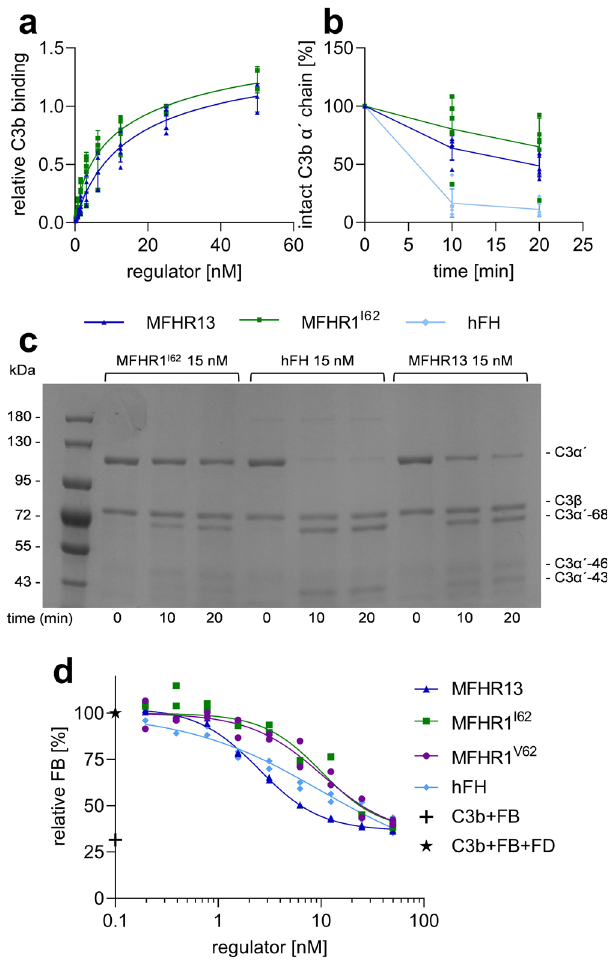
Fig. 6 MFHR13 binds to C3b and exhibits cofactor and decay acceleration activities in fl uid phase. a C3b binding was evaluated by ELISA. Nonlinear regression using the sigmoidal equation (dose – response curve, 4 parameters) and comparison of IC 50 showed no signi fi cant differences between MFHR13 and MFHR I62 binding to C3b ( P = 0.8426). Data represent mean values±SD from 5 independent experiments. Absorbance values from one representative experiment are shown in Supplementary Fig.